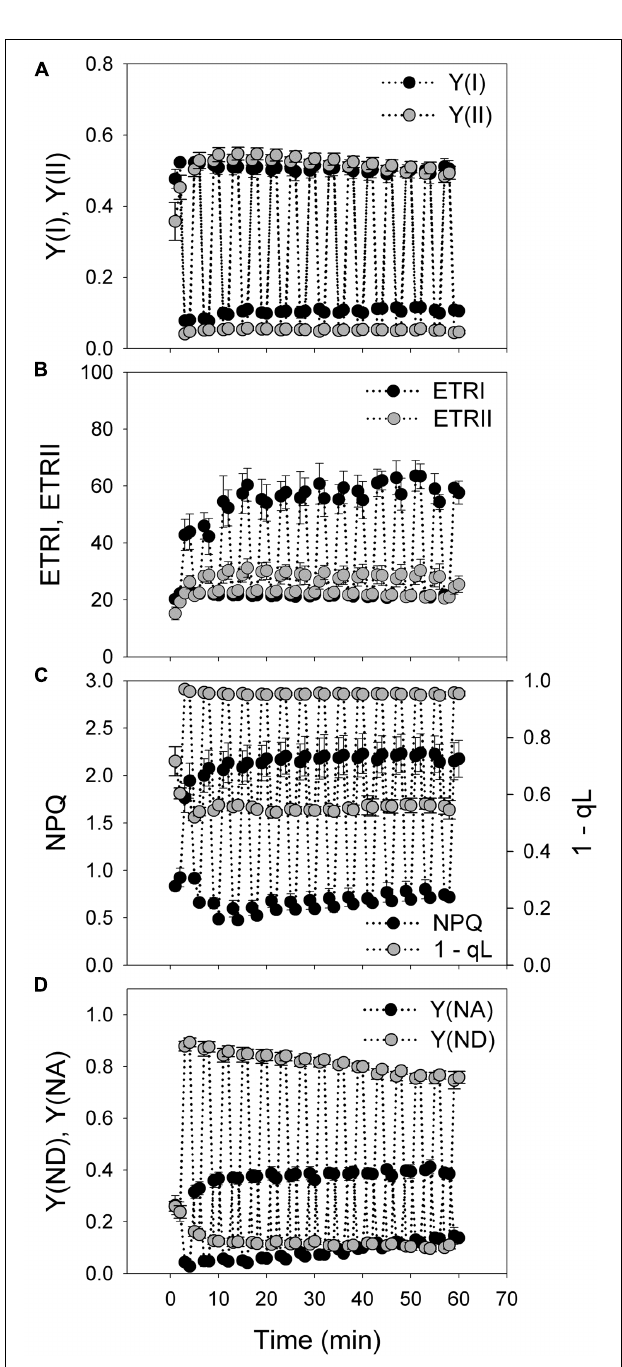
FIGURE 1 | Responses of photosynthetic parameters to moderate fluctuating light in Psychotria henryi . (A) Y(I) and Y(II); (B) ETRI and ETRII; (C) NPQ and 1-qL; (D) Y(ND) and Y(NA). After dark adaptation for 30 min, leaves were exposed to fluctuating light alternating between 100 and 1294 µ mol photons m − 2 s − 1 every 2 min for 60 min. Photosynthetic parameters were measured every 1 min. Y (I), quantum yield of PSI; Y (II), effective quantum yield of PSII; ETRI and ETRII, electron transport rate around PSI (ETRI) and around PSII (ETRII); NPQ, non-photochemical quenching; Y (ND), the fraction of P700 that is already oxidized by actinic light; Y (NA),